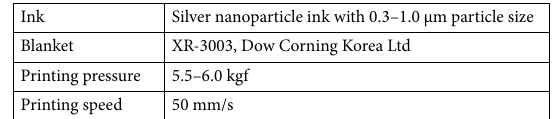
Table 1. Gravure offset printing conditions.